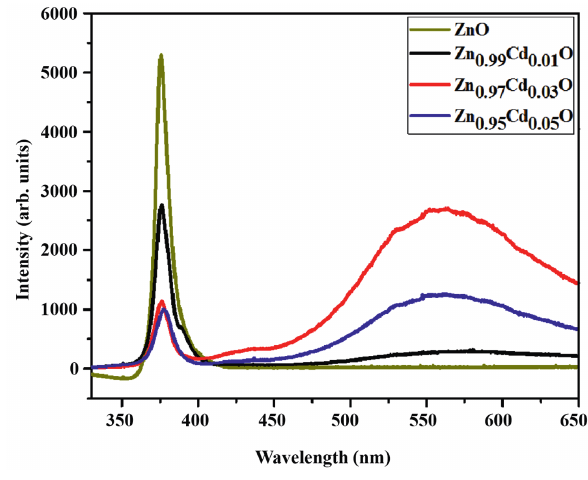
Figure 4: Room temperature PL spectra of Zn 1 – x Cd x O microtubes.